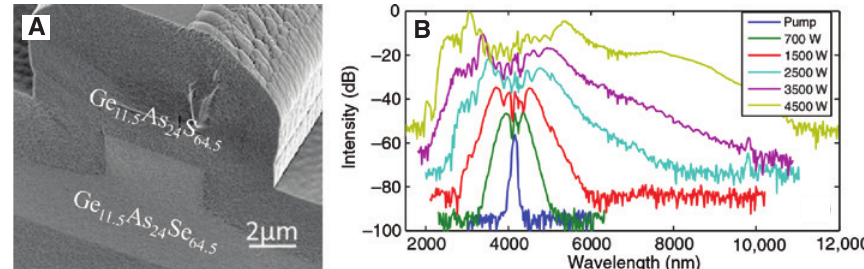
Figure 7: Mid-IR supercontinuum generation in chalcogenide glass waveguides. (A) SEM image of a nonlinear mid-IR ChG waveguide, (B) spectra of supercontinuum generated from the waveguide at different pump peak power levels [115] (© 2016 Optical Society of